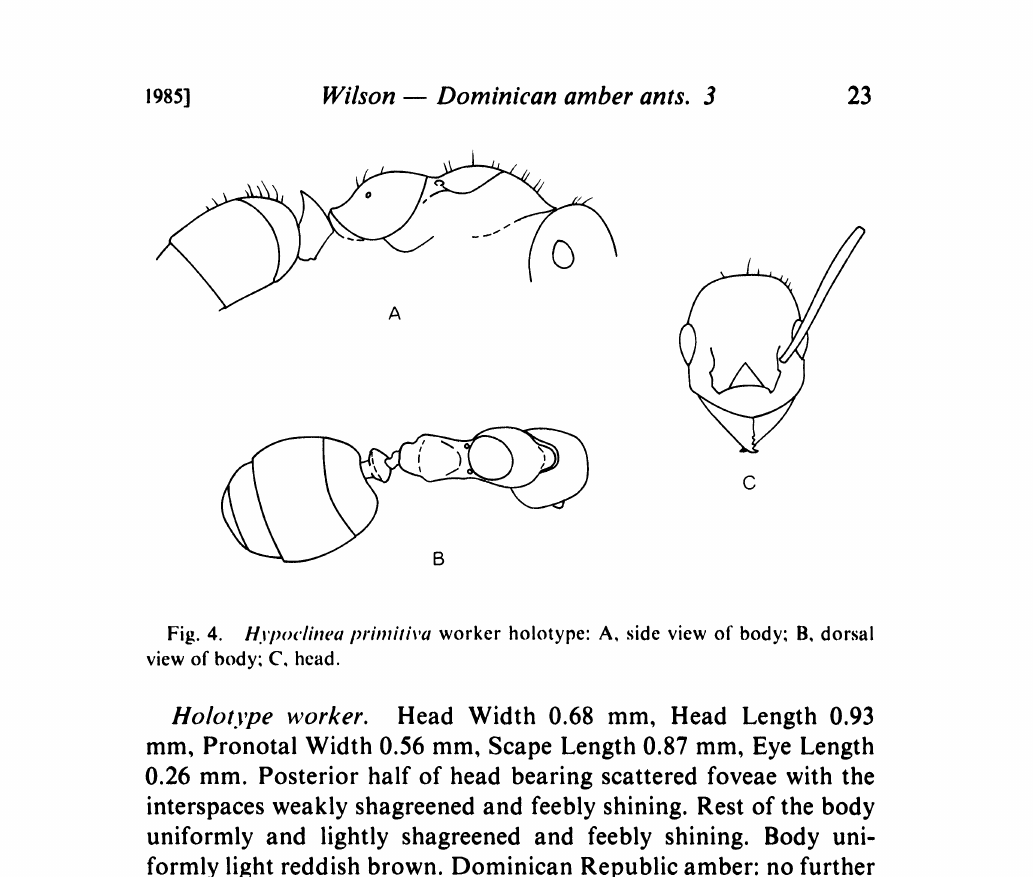
Fig. 4. H.17oclinea primitiva worker holotype: A, side view of body; B, dorsal view of body; C,